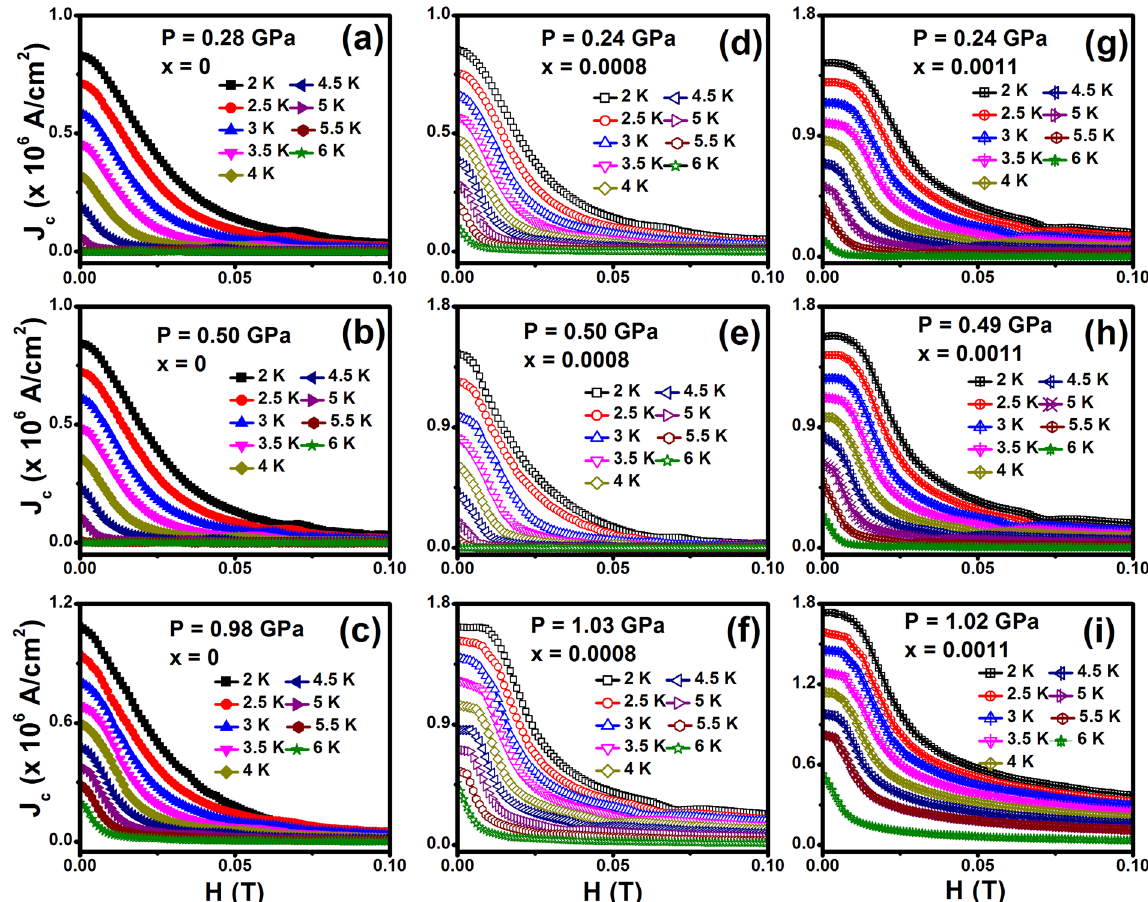
Figure 5. Field dependence of critical current density for ( a – c ) NbSe 2 , ( d – f ) Fe 0.0008 NbSe 2 and ( g – i ) Fe 0.0011 NbSe 2 at various hydrostatic